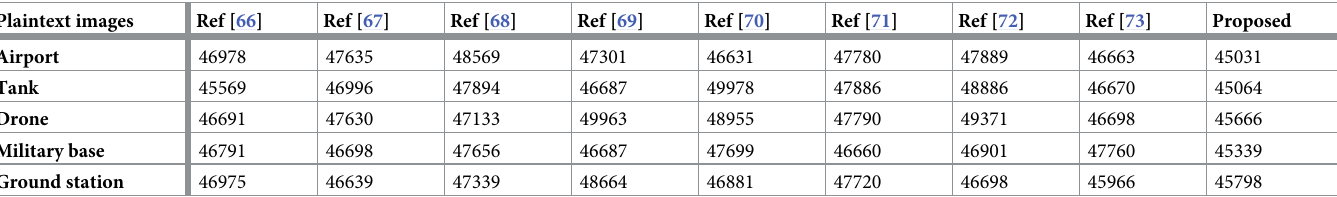
Table 5. Irregular